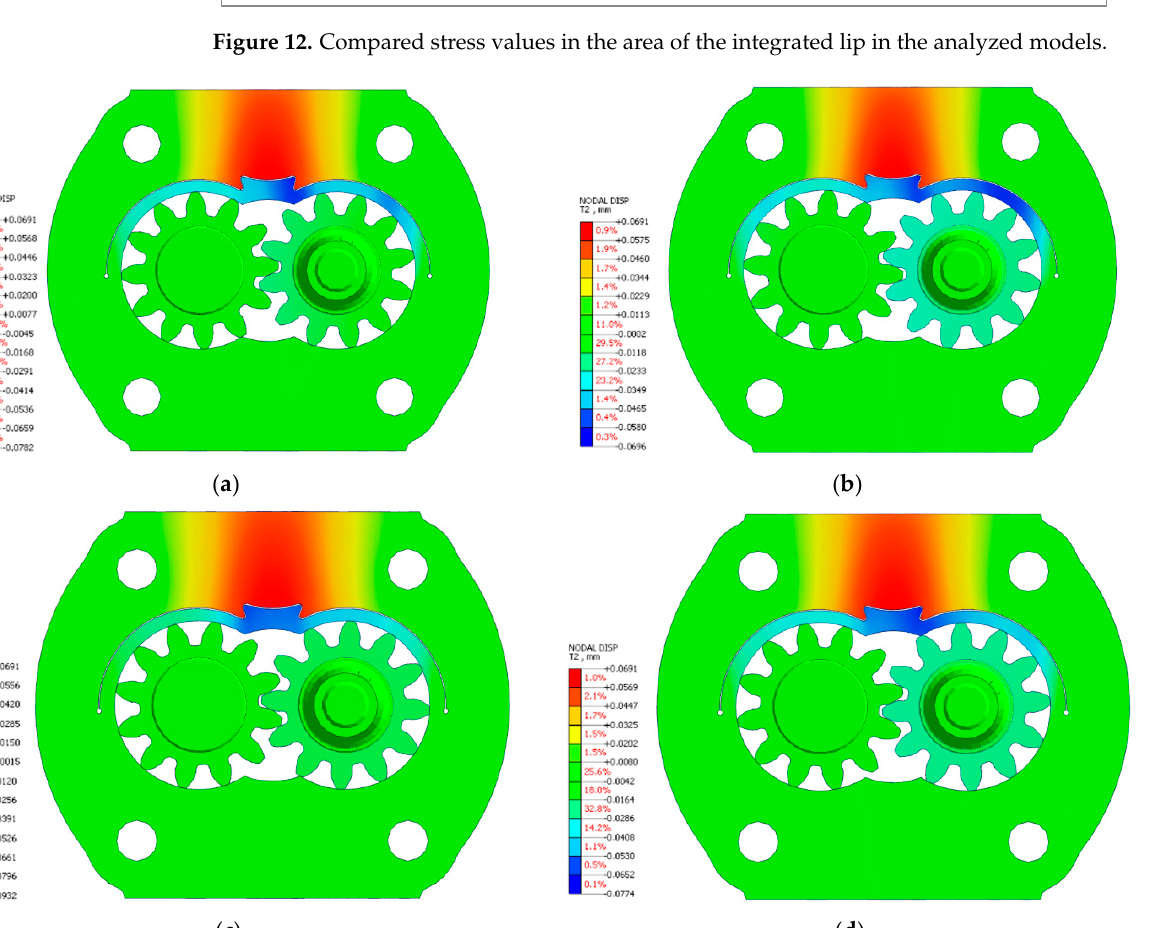
( d ) Figure 14. Distribution of displacements in the Y-axis in casing D, gear rotation angle: ( a ) 0°, ( b ) 7.5°, ( c ) 15°, ( d ) 22.5°. The maximum displacement values of the compensation lip in the investigated mod- els of casings A and D were compared in the form of graphs shown in Figure 15. The